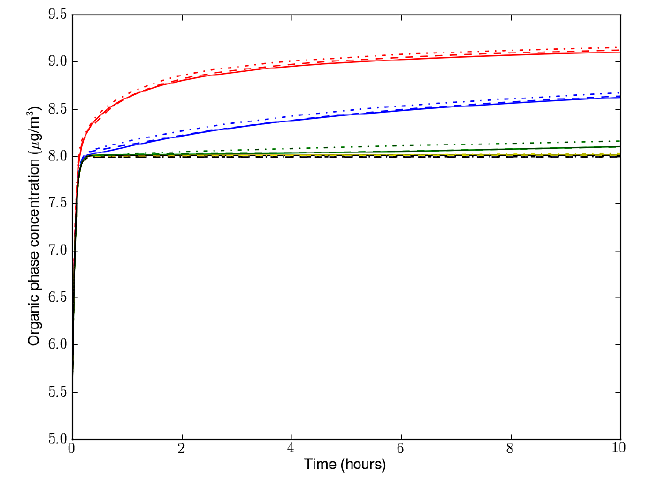
Figure 7. Comparison between the explicit representation (plain lines) and the implicit representation for N layer = 5 (– line) and N layer = 4 (-. line) for several organic-phase diffusivity: D org = 10 − 19 m 2 s − 1 (red), D org = 10 − 20 m 2 s − 1 (blue), D org = 10 − 21 m 2 s − 1 (green), D org = 10 − 22 m 2 s − 1 (yellow) and D org = 10 − 24 m 2 s − 1 (black) for the compounds from biogenic test case (with an initial concentrations inside the particle equal to 10% of the concentration at equilibrium) condensing on 5µgm − 3 of non- volatile organic compounds at RH = 30%. Ideality is assumed.